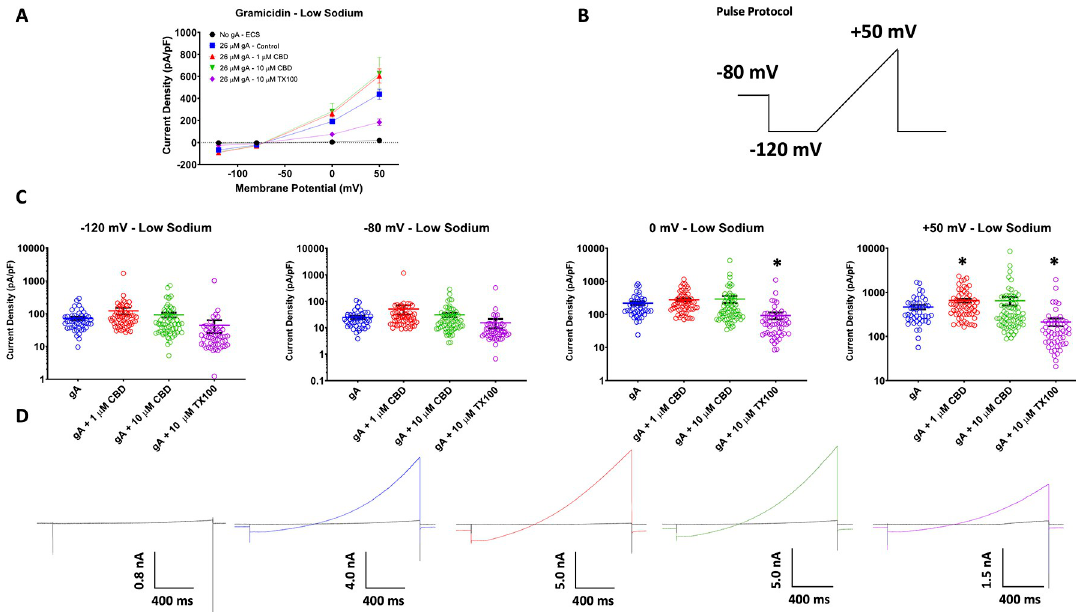
Fig 2. Low sodium voltage-clamp. Shows the averaged cationic current densities of gramicidin in the presence/absence of CBD at 1 and 10 μ M, and TX100 at 10 μ M (in pA/pF, ECS: -120 mV = -4.1 ± 0.9, -80 mV = -3.5 ± 0.7, 0 mV = 4.1 ± 0.4, +50 mV = 18.8 ± 1.7, n = 33; gA: -120 mV = -67.6 ± 7.7, -80 mV = -23.0 ± 2.9, 0 mV = 189.8 ± 20.6, +50 mV = 437.4 ± 45.6, n = 45; 1 μ M CBD: -120 mV = -90.9 ± 9.0, -80 mV = -30.6 ± 2.9, 0 mV = 261.7 ± 28.7, +50 mV = 604.0 ± 64.8, n = 55; 10 μ M CBD: -120 mV = -83.6 ± 14.1, -80 mV = -27.8 ± 5.2, 0 mV = 280.8 ± 74.4, +50 mV = 624.9 ± 149.6, n = 60; 10 μ M TX100: -120 mV = -26.3 ± 3.5, -80 mV = -9.7 ± 1.3, 0 mV = 74.2 ± 11.3, +50 mV = 182.4 ± 29.0, n = 50). (B) Shows the ramp voltage protocol. (C) Shows quantification of the data shown in (A), stars indicate statistical significance. (D) Shows the associated current